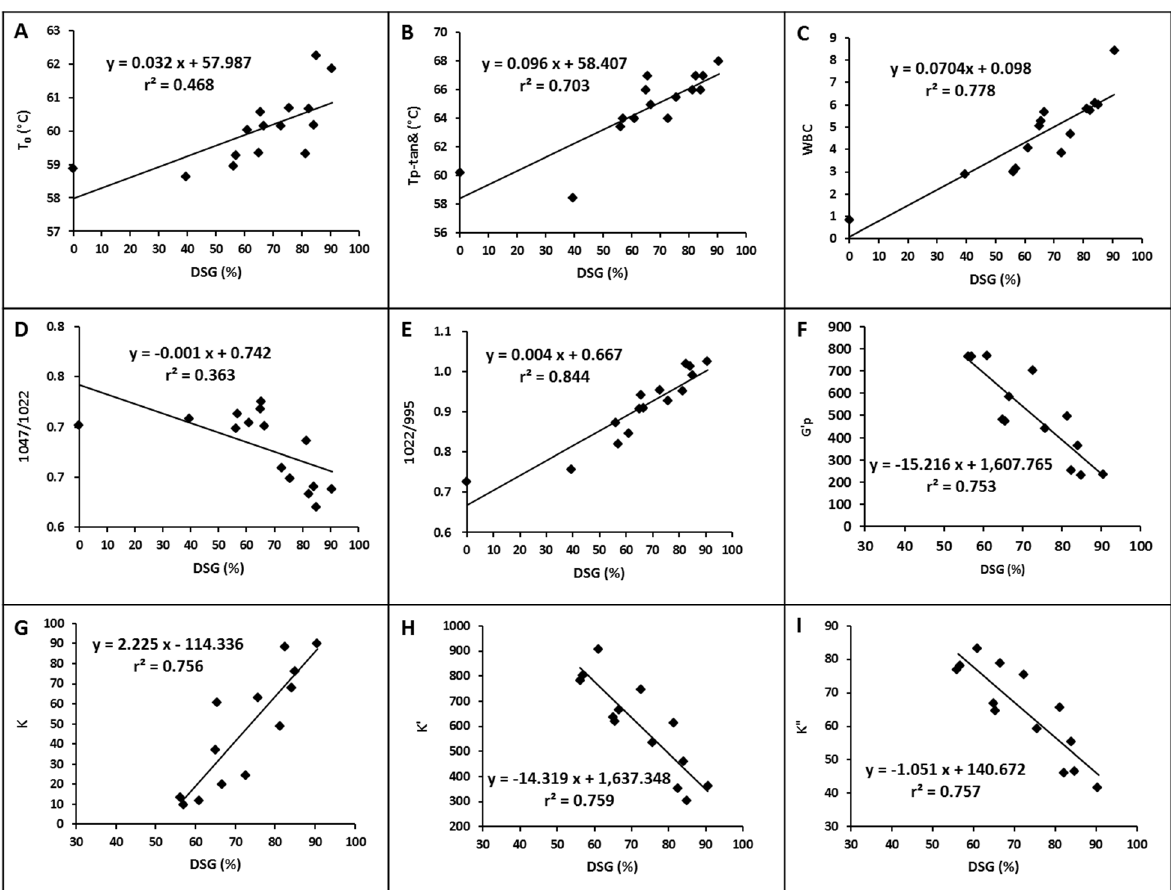
Figure 4. Relationship between the physicochemical properties of potato starch and its degree of gelatinization ( A : T 0 from DSC; B : temperature at the peak tanδ from temperature sweep; C : WBC at 20 °C; D : ratios of absorbance 1047/1022 cm −1 from FTIR; E : ratios of absorbance 1022/995 cm −1 from FTIR; F : peak G’ from temperature sweep; G : K value from steady shear test; H : K’ value from frequency sweep; I : K” value from frequency sweep).